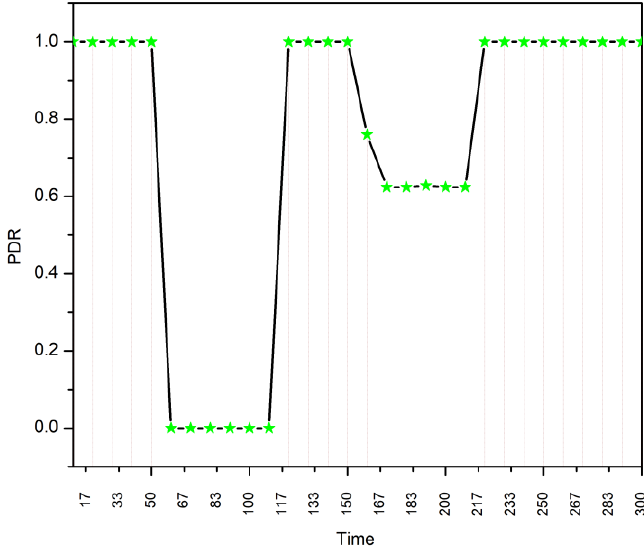
Figure 10. Resiliency curve using the simulation framework of the SCN.